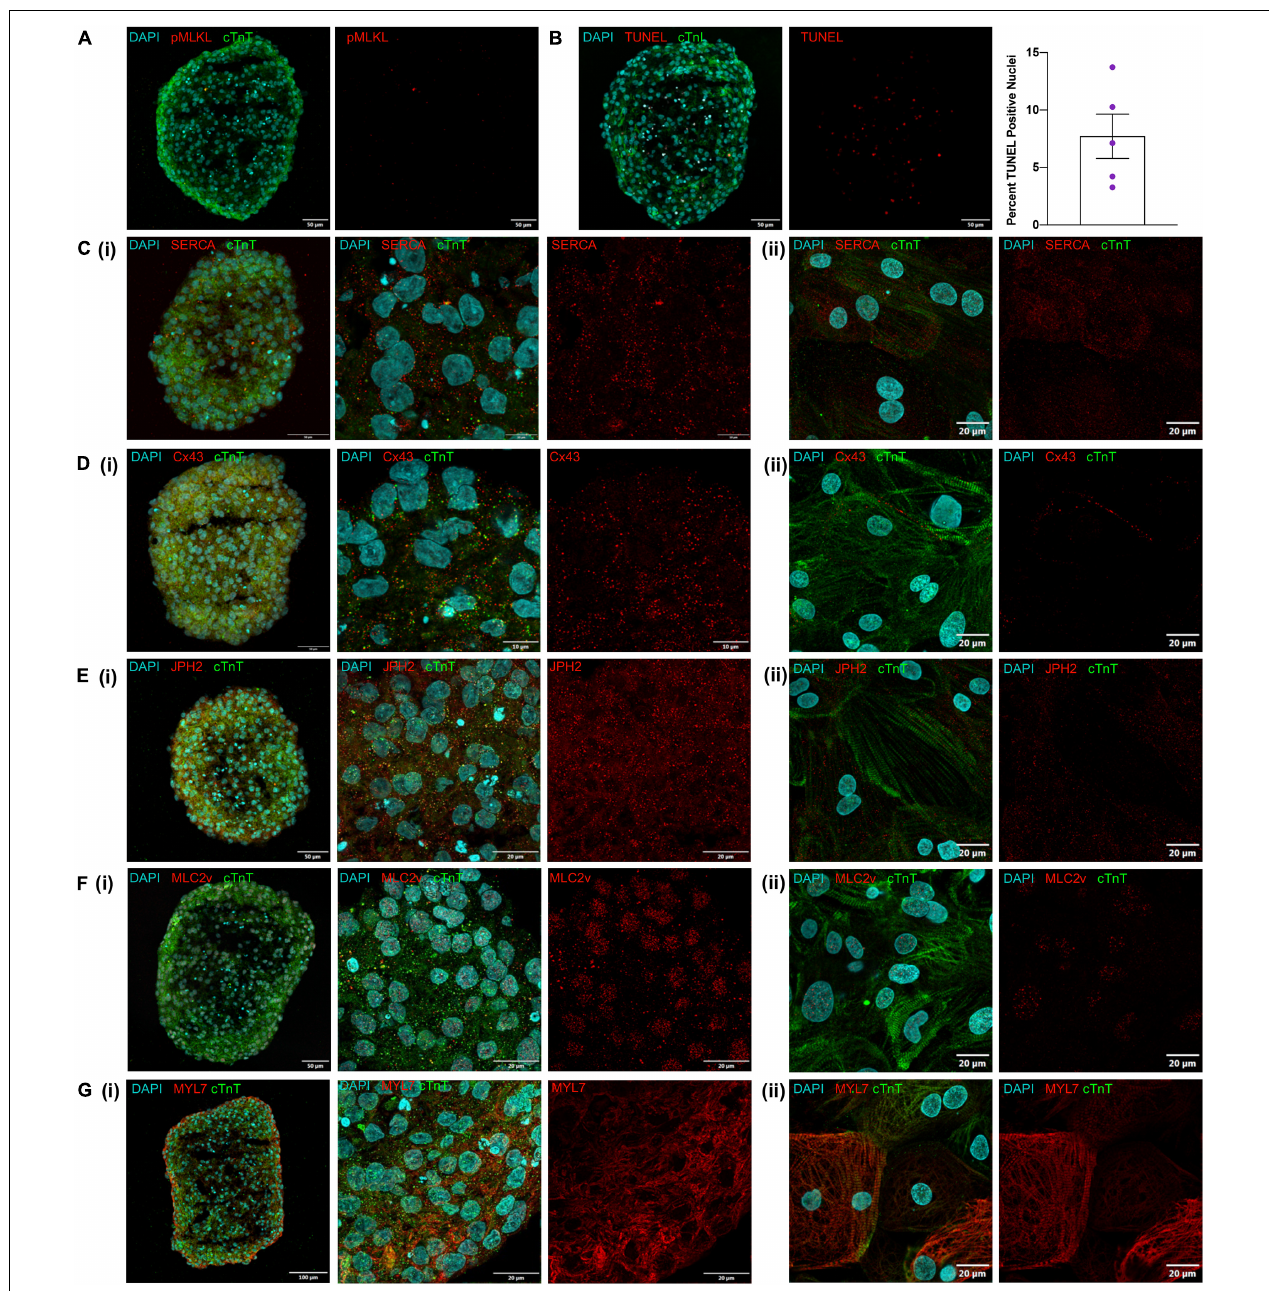
FIGURE 3 | Visual characterization of iCMs produced in suspension. (A) Day 12 cryosection stained for pMLKL showing no positive nuclei. (B) Day 12 cryosection with TUNEL staining and quantification of percent positive nuclei from examination of 5 spheroids. (C–G) Immunofluorescent antibody staining of day 12 suspension cardiomyocytes for cTnT and (C) SERCA, (D) Cx43, (E) JPH2, (F) MLC2v, and (G) MYL7 as (i) cryosections at low and high magnification and (ii) dissociated spheroids cultured for 3 days as